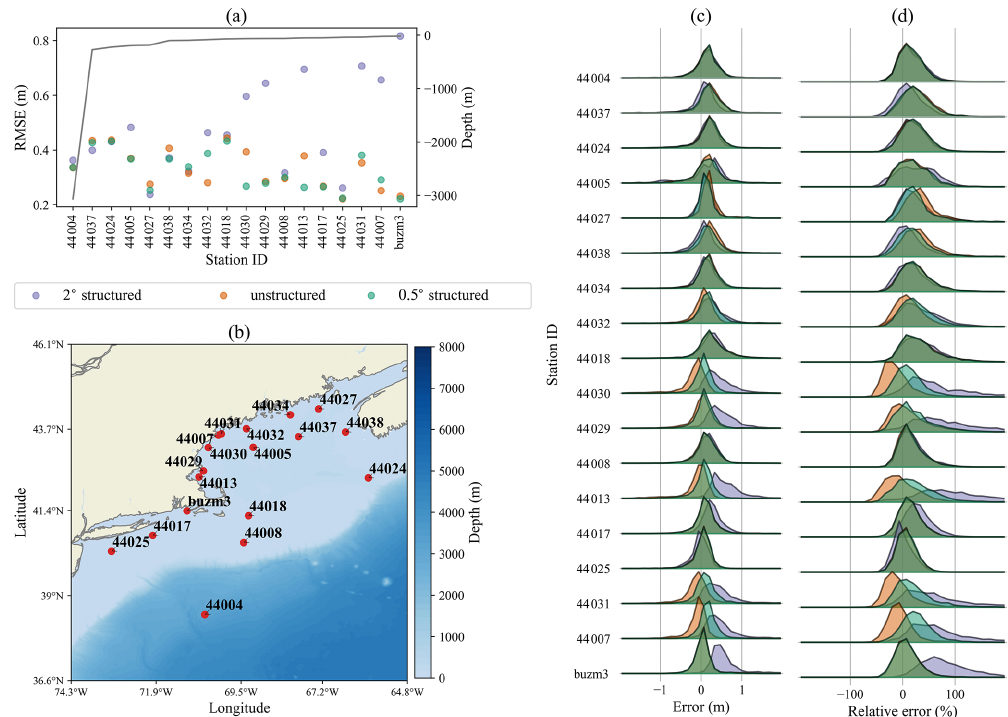
Figure 3. Comparison between modeled results and NDBC buoy data for the 2 ◦ structured, unstructured, and 0.5 ◦ structured meshes in the Gulf of Maine region. (a) Root mean squared errors (dots) for each mesh resolution along with station depth (gray line). (b) Geographic location of each station. (c) Normalized distribution of bias errors between the model and observations over the simulated time period. (d) Normalized distribution of relative errors. Table 3. Comparison of average absolute relative errors (%) between deep (depth > than 1000m) and coastal (depth ≤ 1000m) stations for each mesh. The regions shown correspond to those found in Figs. 3–10. Deep Coastal Region (section) 2 ◦ Unstructured 0.5 ◦ 2 ◦ Unstructured 0.5